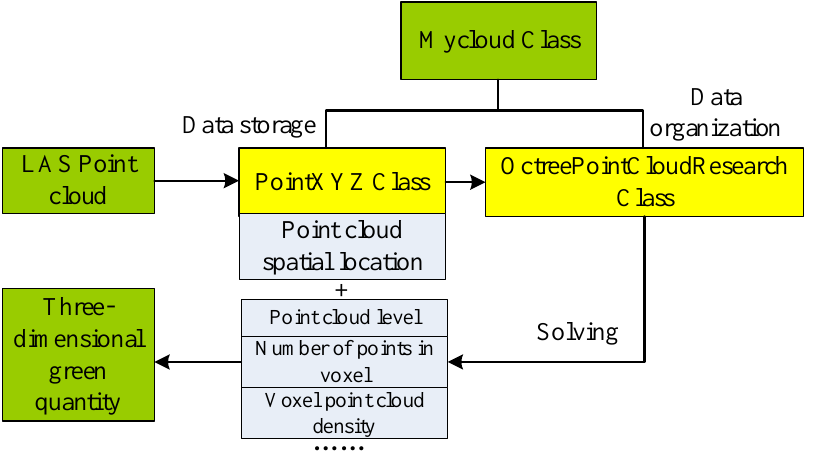
Figure 3. Mycloud class design diagram.